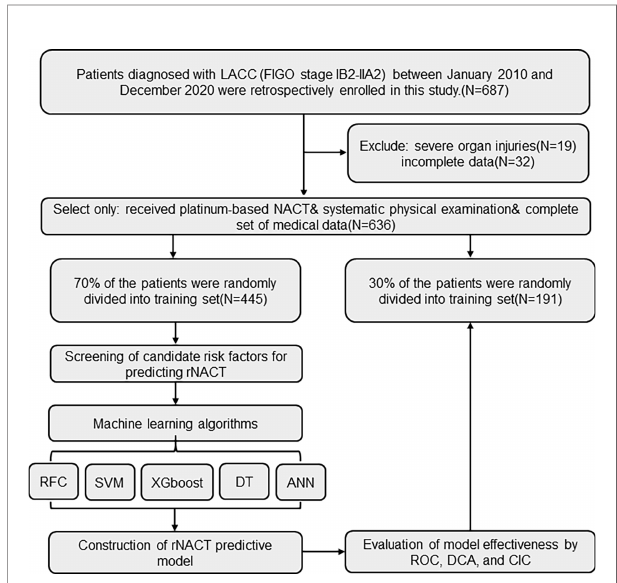
FIGURE 1 | Flow diagram of patient selection and data processing. ANN, arti fi cial neural network; CIC, clinical impact curve; DCA, decision curve analysis; DT, decision tree; FIGO, International Federation of Gynecology and Obstetrics; RFC, random forest classi fi er; ROC, receiver operating characteristic; SVM, support vector machine; XGboost, eXtreme gradient